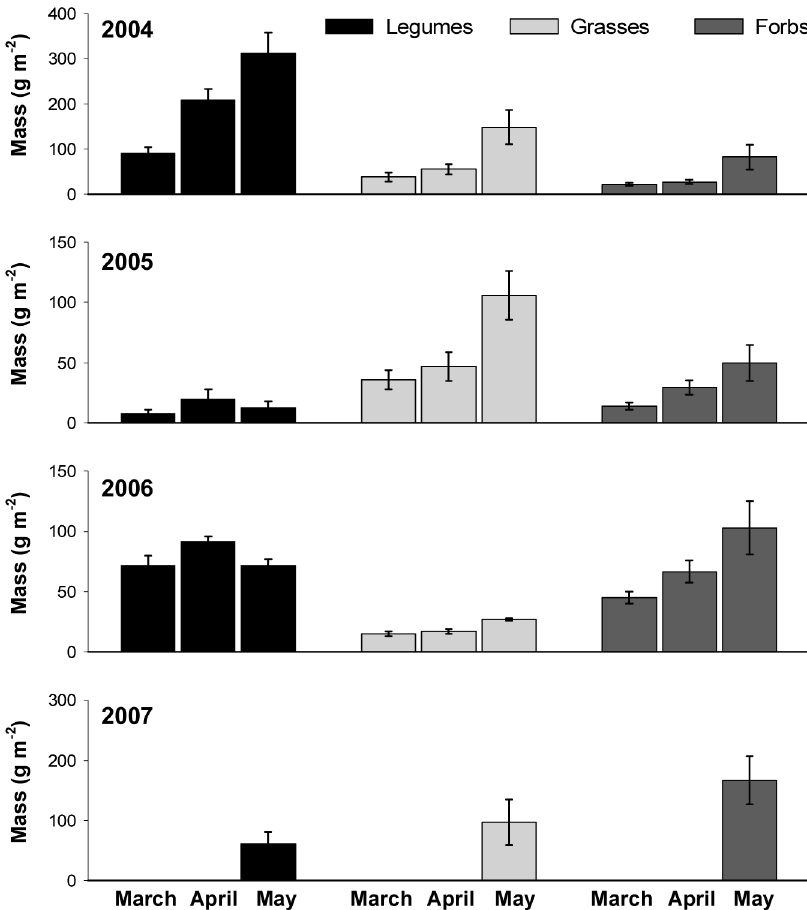
Fig. 3. Mass of legumes, grasses and forbs (g m –2 ), determined in gaps of the low Macchia at Castel Volturno nature reserve in spring. Values are means of 18 measurements at each harvest. Note the different scale used for 2005 and